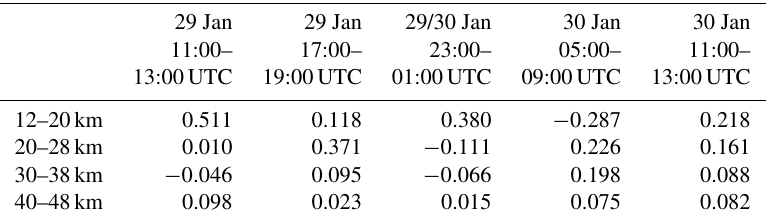
Table 4. Stratospheric vertical energy fluxes p (cid:48) w (cid:48) in Wm − 2 from the IFS HRES analyses and short-term forecasts averaged over the area 68 to 69 ◦ N and 18 to 22 ◦ E over the respective times and altitude